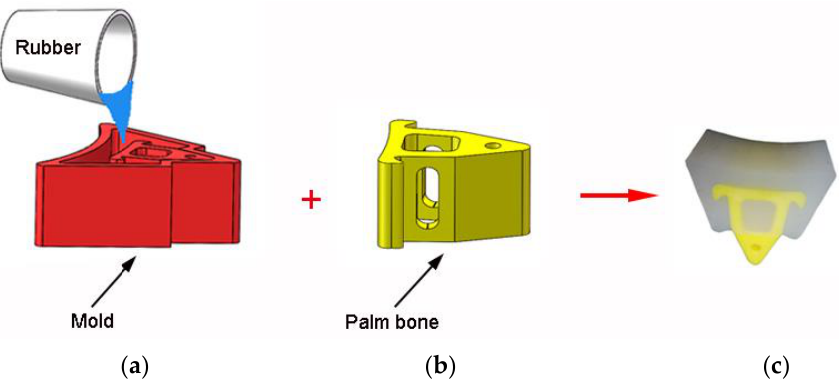
Figure 4. Gripper palm. ( a ) Filled with silicone gel; ( b ) palm fabrication; ( c ) palm physical assembly.